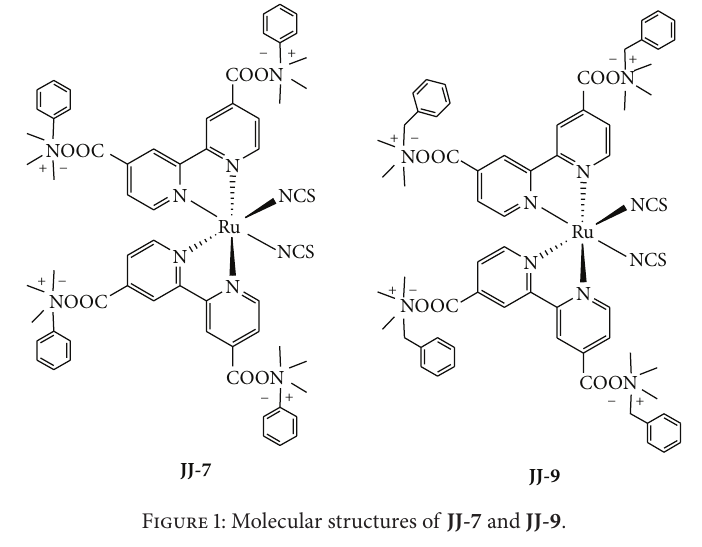
Figure 1: Molecular structures of JJ-7 and JJ-9